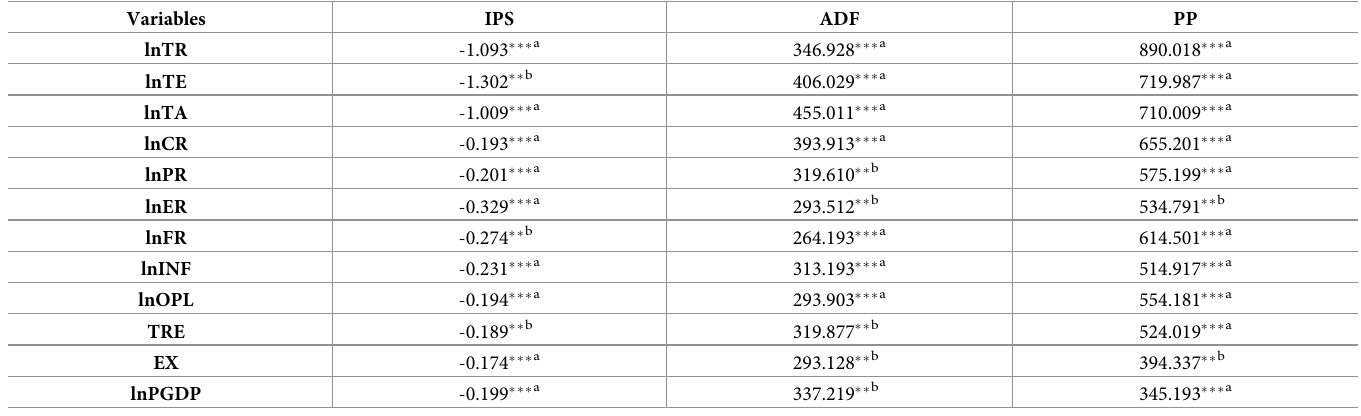
a ��� indicates the rejection of null hypotheses at 1% significance level, the same below. b �� indicates the rejection of null hypotheses at 5% significance level, the same